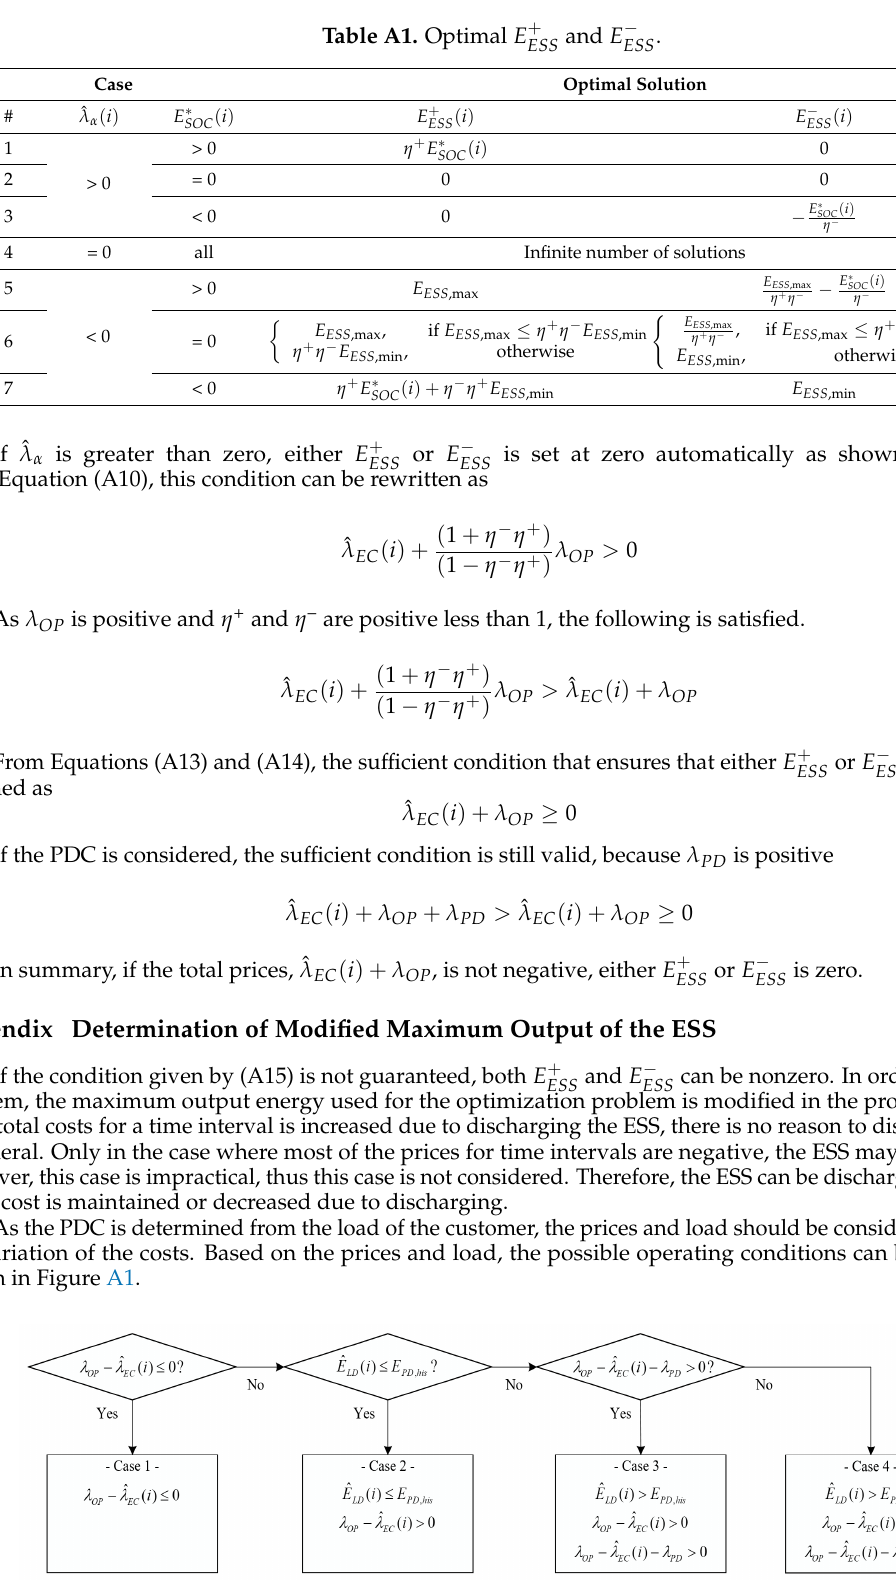
Figure A1. Possible operating conditions.